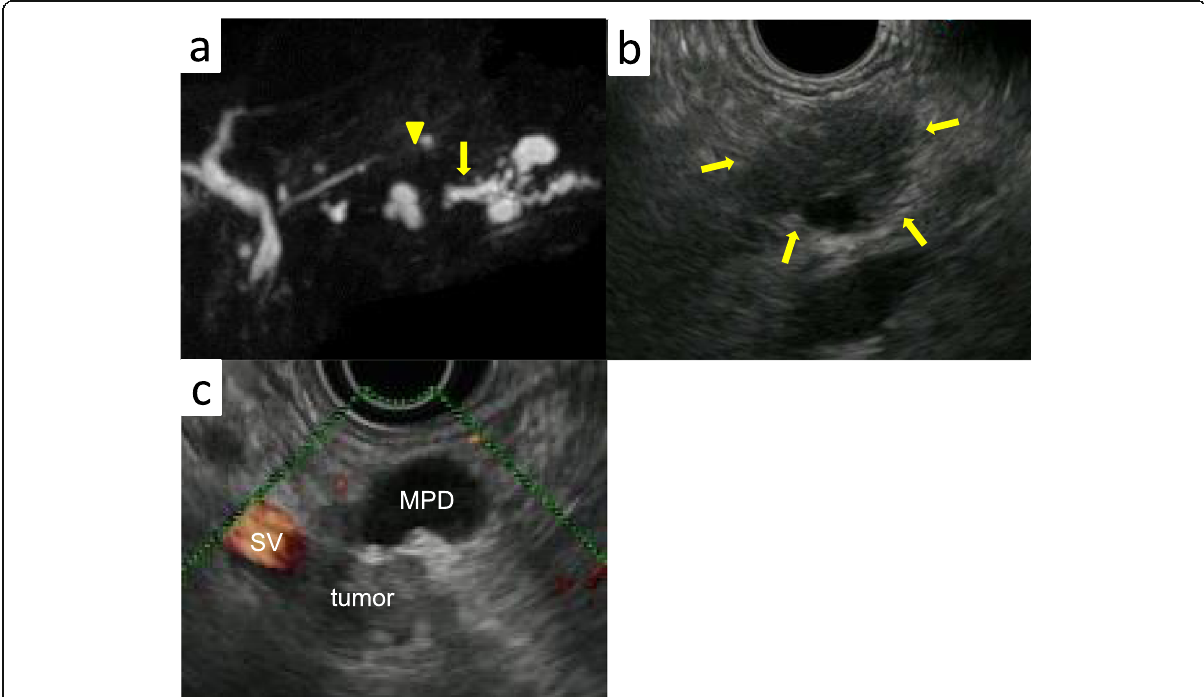
Fig. 2 Magnetic resonance cholangiopancreatography examination. a Magnetic resonance cholangiopancreatography examination showing MPD disruption (yellow arrow) in pancreatic body and MPD dilation in the distal side of the disruption (yellow arrowhead). b , c EUS showed a 21-mm hypoechoic lesion near the calcification (yellow arrow). Invasion to the splenic vein by the tumor was suspected. MPD, main pancreatic duct; EUS, endoscopic ultrasonography; SV, splenic vein